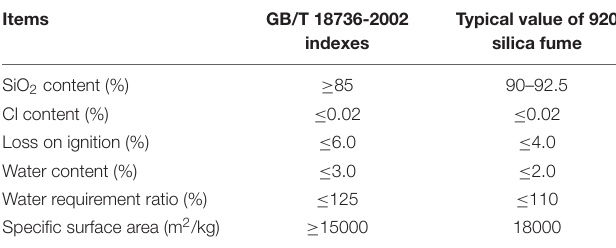
TABLE 2 | Technical indexes of the silica fume.